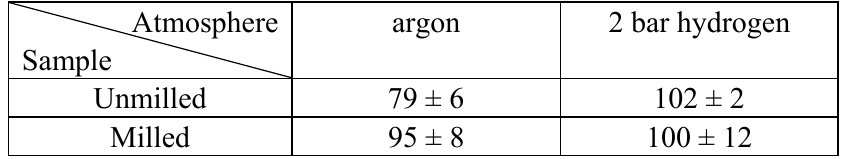
Table 3. Activation energies in kJ/mol of the exothermic peak of unmilled and one hour milled LiBH